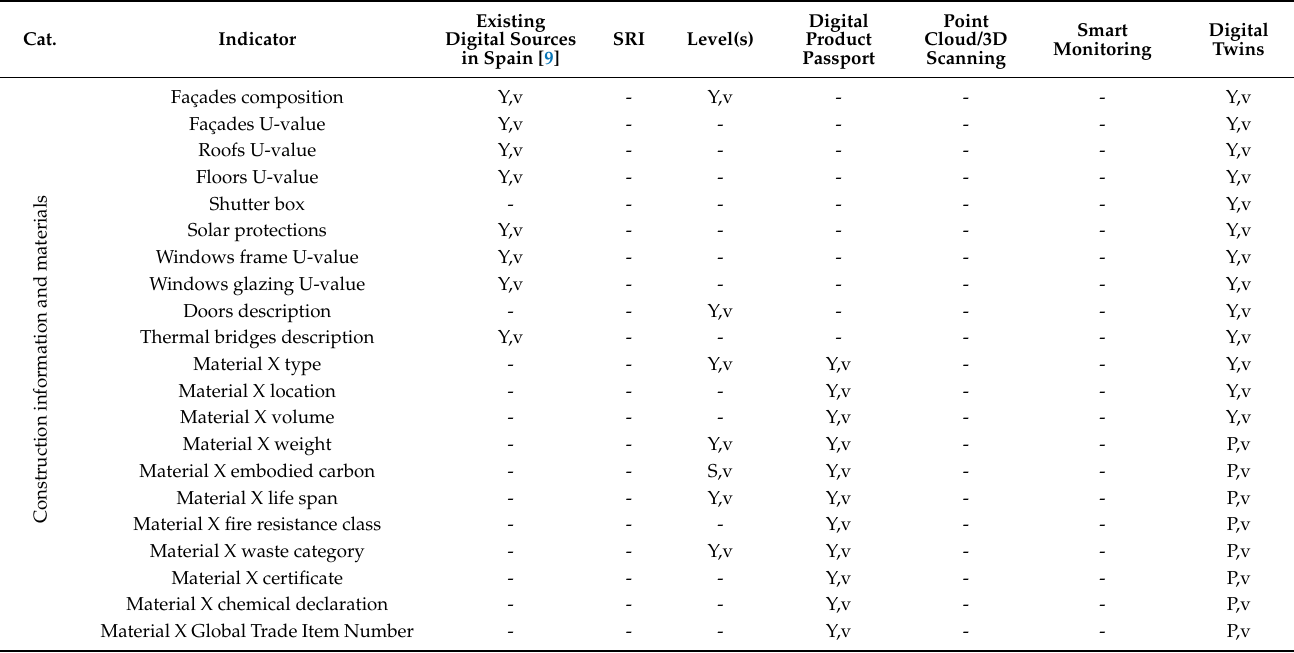
- - - - - - Table A2. Category 2: Construction information and